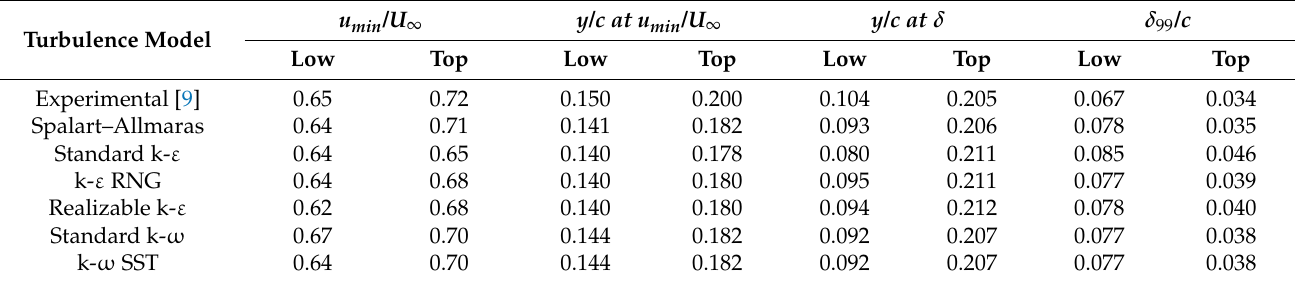
Figure 5. Turbulence model effect: ( a ) surface pressure at h/c = 0.211, ( b ) wake profile at x/c = 1.066 for h/c = 0.211, ( c ) surface pressure at h/c = 0.079, and ( d ) wake profile at x/c = 1.066 for h/c = 0.079. Table 5. Information on wake profiles for several turbulence models at x/c = 1.066 for h/c =